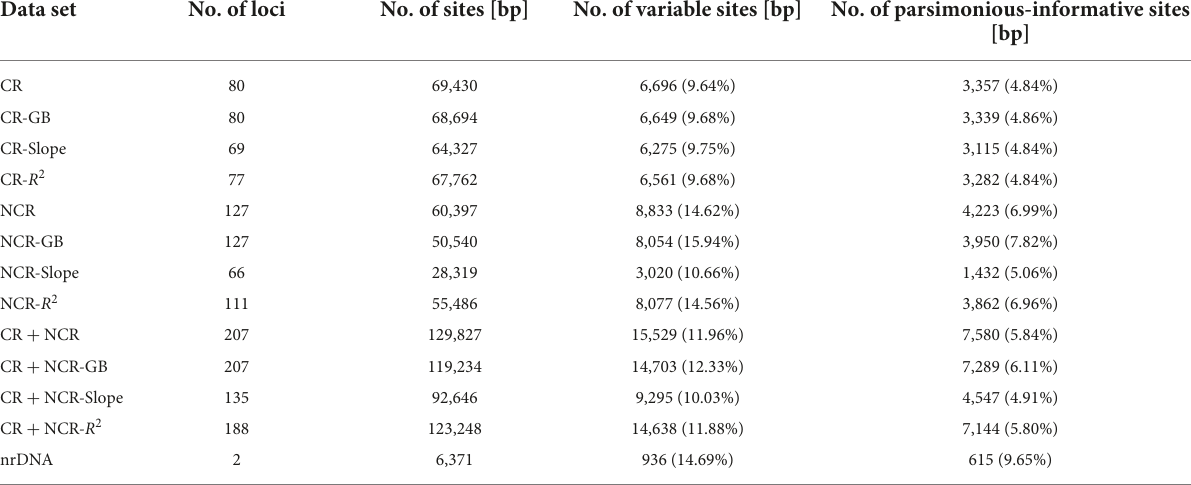
TABLE 1 Detailed characteristics of all plastome data sets and the combined nrDNA data set used in present study. Data